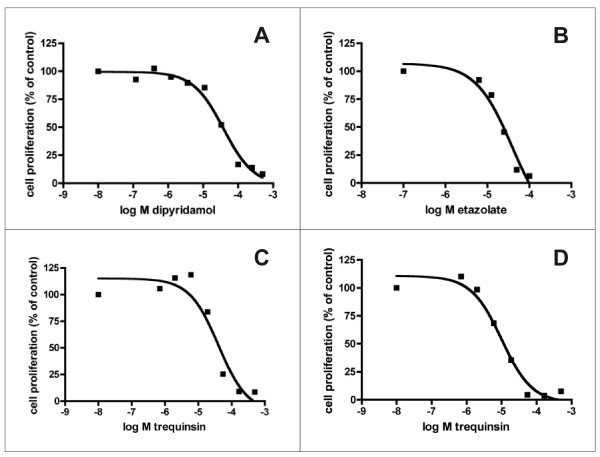
Inhibition of cell proliferation in culture. The EC50 values for L. major promastigote proliferation were determined for dipyridamole (panel A), etazolate (panel B) and trequinsin (panel C). Panel D represents an EC50 determination for trequinsin with L. infantum amastigotes. EC50 values were determined various time points and cell densities, and all growth experiments were repeated at least three times. Representative growth curves for each inhibitor are shown. EC50 values for all inhibitors were in the 30 – 100 μM range for both promastigotes and amastigotes.